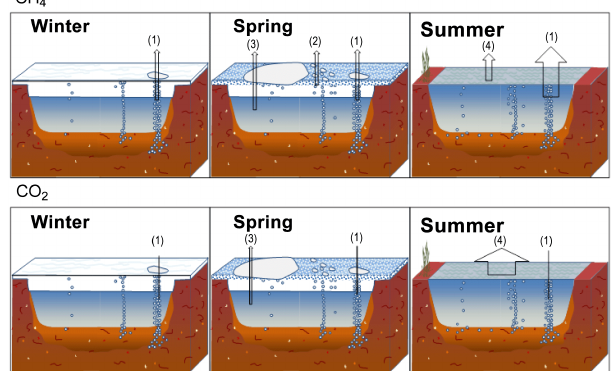
Figure 4. Illustration of CH 4 and CO 2 emissions pathways dur- ing different seasons in Alaskan lakes. The thickness of arrows in- dicates the relative magnitude of contribution from each pathway according to Table 2: (1) direct ebullition through ice-free hotspot seeps in winter and from all seep classes during the last month of ice cover in spring and in summer, (2) ice-bubble storage (IBS) emis- sion during spring ice melt, (3) storage emission of dissolved gases accumulated under lake ice when ice melts in spring, and (4) diffu- sion emission from open water in